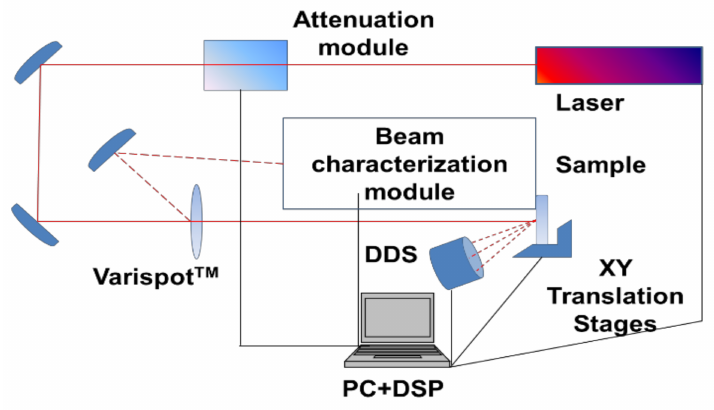
Figure 1. Automated nanosecond LIDT test station. DDS—real time damage detection system coupled with central DSP unit, PC+DSP—command computer and digital signal